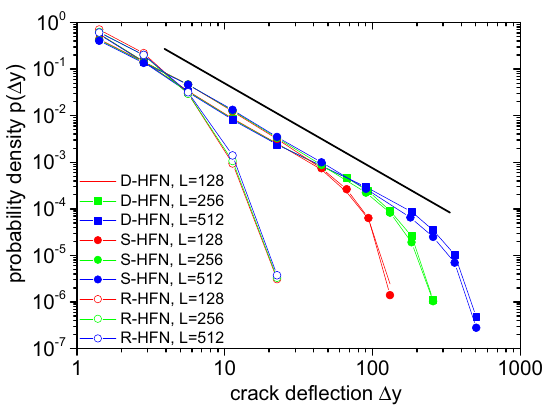
Figure 5. Crack morphology. Distributions p ( Δ y ) of crack deflections in the load-parallel direction for deterministic, shuffled and rotated HFNs of sizes L = 128, L = 256 and L = 512: the straight line represents a power law of exponent θ =